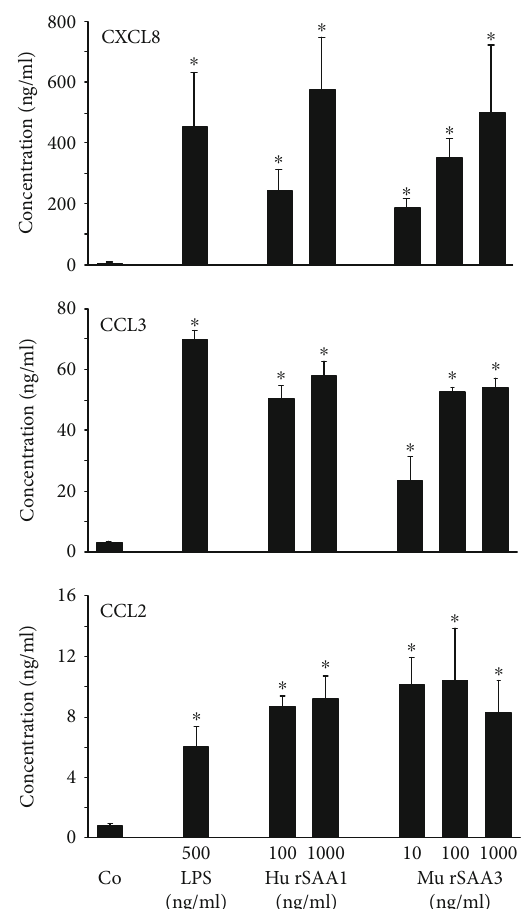
Figure 2: Impure mu rSAA3 induces chemokines in human CD14 + monocytes. Human CD14 + monocytes derived from bu ff y coats of healthy individuals were stimulated with LPS (500ng/ml), hu rSAA1 (100 or 1000ng/ml), mu rSAA3 (10-1000ng/ml) or were left untreated (Co). After 24h, supernatants were collected and levels of CXCL8, CCL3 and CCL2 were determined via speci fi c ELISAs. Data represent the mean production of chemokine ± SEM derived from 4 independent experiments. Statistically signi fi cant di ff erences from untreated control cells, determined by the Mann- Whitney U test, are indicated by asterisks ( ∗ p < 0 : 05